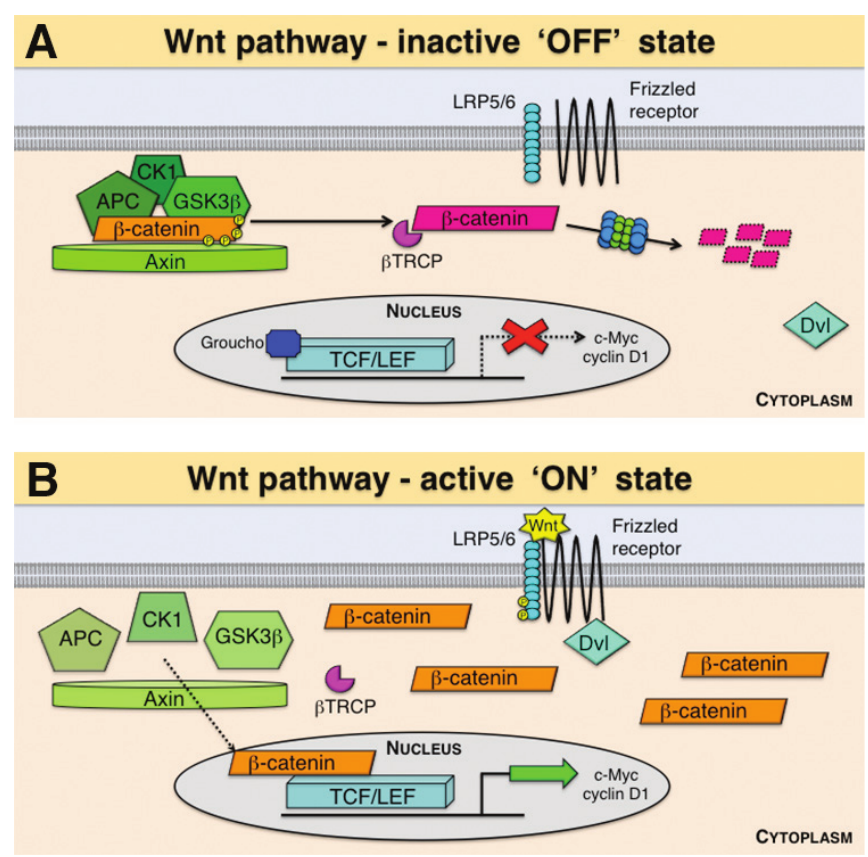
Figure 2. The canonical Wnt/ β -catenin pathway. In the absence of a Wnt signal (‘OFF’ state), the destruction complex, con- sisting of adenomatosis polyposis coli (APC), glycogen synthase kinase 3- β (GSK3 β ), casein kinase 1 (CK1) and Axin, binds and phosphorylates β -catenin, marking it for ubiquitination by the E3 ubiquitin ligase subunit beta-transducin repeat containing protein ( β TRCP) and degradation through the proteasome. In this case, the repressor Groucho remains bound to T-cell factor/ lymphoid enhancer factor (TCF/LEF) transcription factors, inhibiting transcription of target genes such as c-Myc and cyclin D1 (A). When a Wnt protein binds a Frizzled receptor and the low-density lipoprotein receptor-related proteins 5 and 6 (LRP5/6) in the ‘ON’ state, the protein dishevelled (Dvl) activates a cascade, which eventually disrupts the destruction complex, leading to sta- bilisation, cytoplasmic accumulation and nuclear translocation of β -catenin and ultimately the transcription of target genes